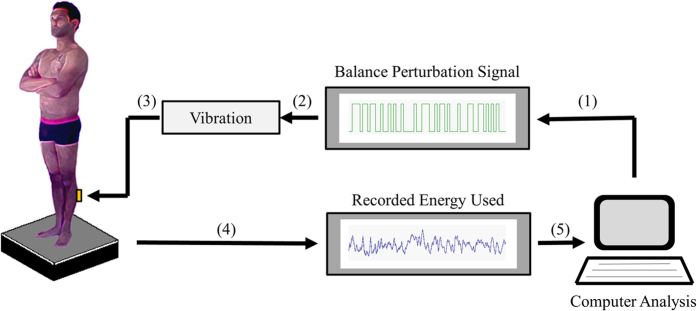
Schematic illustration of the posturography setup.The posturography software produces (1) a pseudorandom binary sequence (PRBS), which is (2) converted to vibration pulses. Vibration pulses applied towards (3) the calf muscles cause balance perturbations. The energy used (4) towards the support surface, reflecting the effort to maintain stability, is recorded by a force platform and quantified by the posturography software (5).